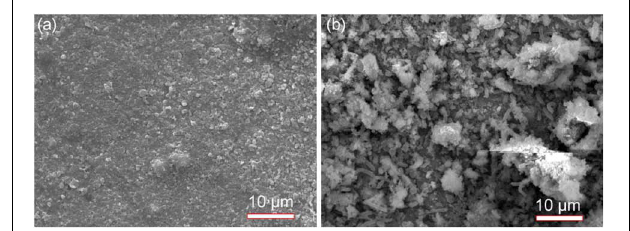
FIGURE 2 | Scanning electron microscopy images of specimens with covered deposit after 14-days of incubation in the absence (a) and presence (b) of SRB in CO 2 -saturated simulated formation water.